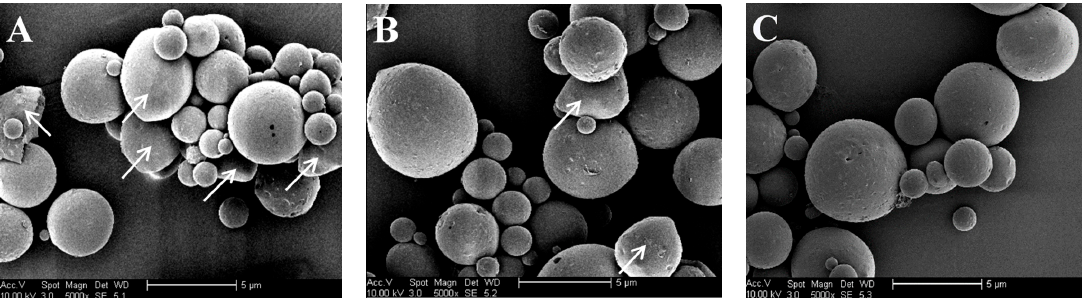
Figure 2. Representative scanning electron microscopy (SEM) micrographs for ( A ) CH-I; ( B ) CH/HA-II(b) and ( C ) CH-PLA/HA-II(b) microspheres (arrows denote the cracked clumps and irregularly shaped beads).